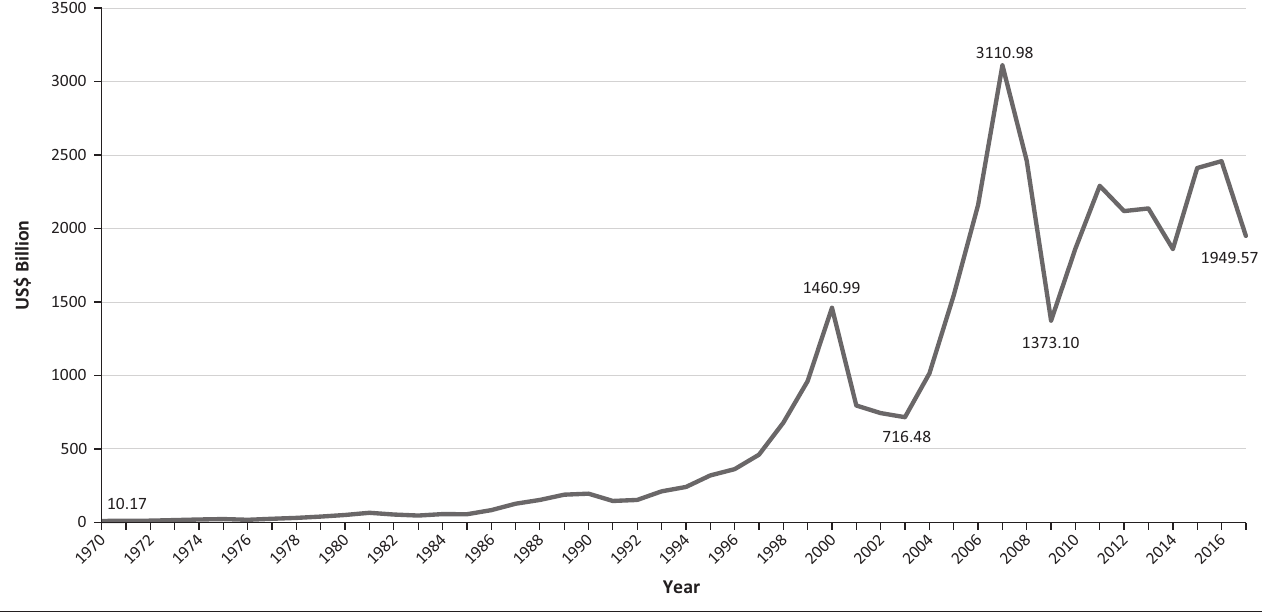
FIGURE 1: Global net inflows of foreign direct investment from 1970 to